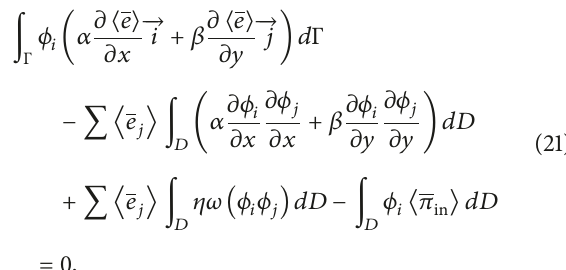
equation should be obtained via the variation method. The linear equation